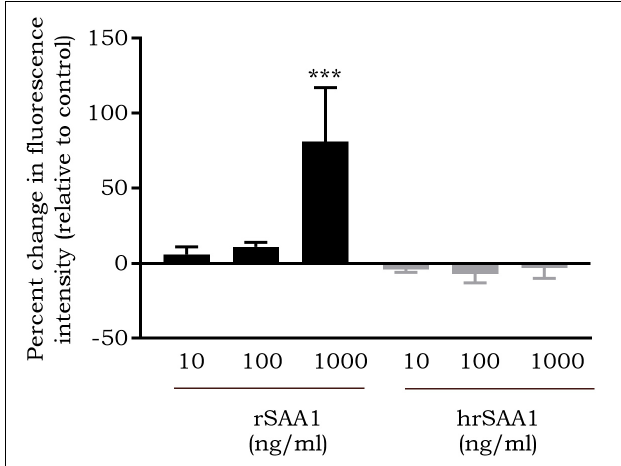
FIGURE 5 | hrSAA1 does not induce ROS production in CD14 + monocytes. Freshly isolated monocytes were stimulated with homogenous rSAA1 (hrSAA1) (10–1000 ng/ml, 0.8–80 nM) in parallel with rSAA1 (10–1000 ng/ml, 0.8–80 nM). Following an incubation period of 1 h, staining with 2 (cid:48) ,7 (cid:48) -dichlorofluorescein diacetate (50 µ M) was carried out and flow cytometry was used to quantify ROS production. Results are presented as the mean percent change in fluorescence intensity in comparison to buffer-treated cells + SEM (i.e., 0% is equivalent to the same fluorescence intensity as obtained for buffer-treated cells) and are derived from four to seven independent experiments. Significant upregulation in comparison to control is indicated by asterisks (Mann-Whitney U -test; *** p -value <